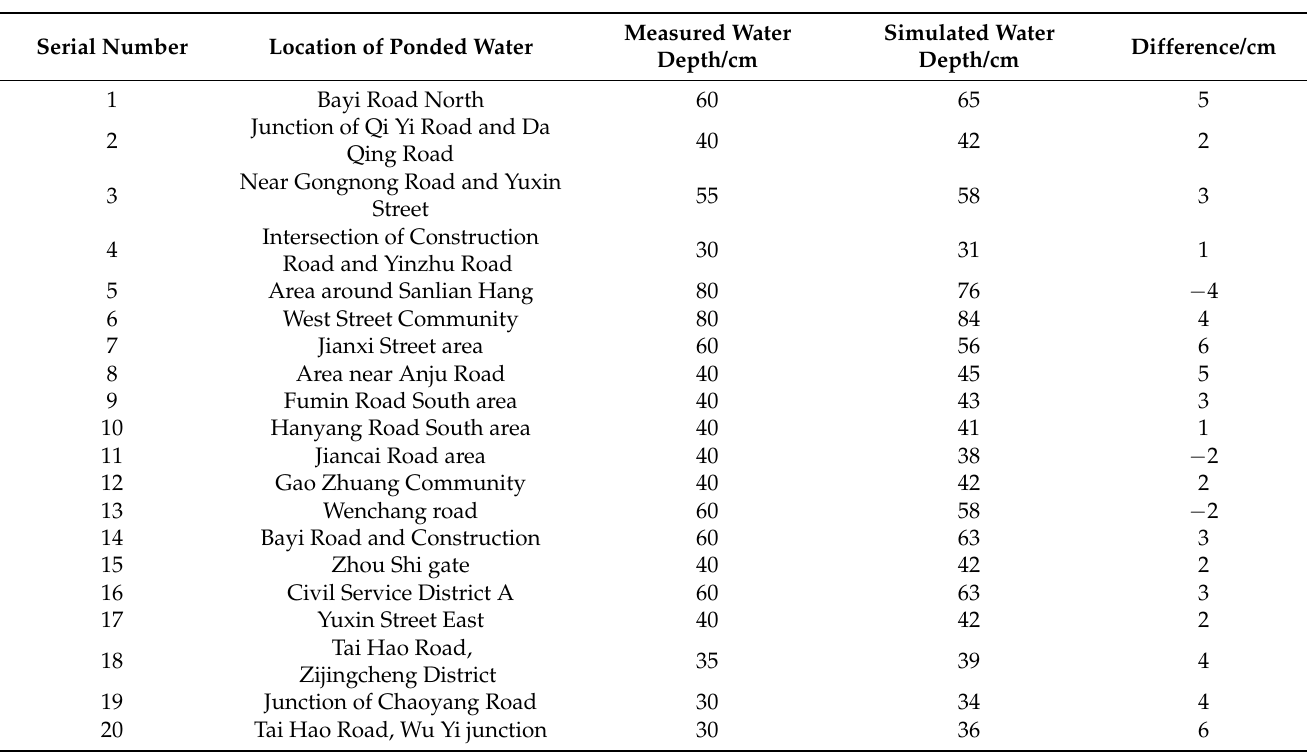
Table 2. Comparison of measured and numerically modelled ponding depths at inundated water points on 20 July